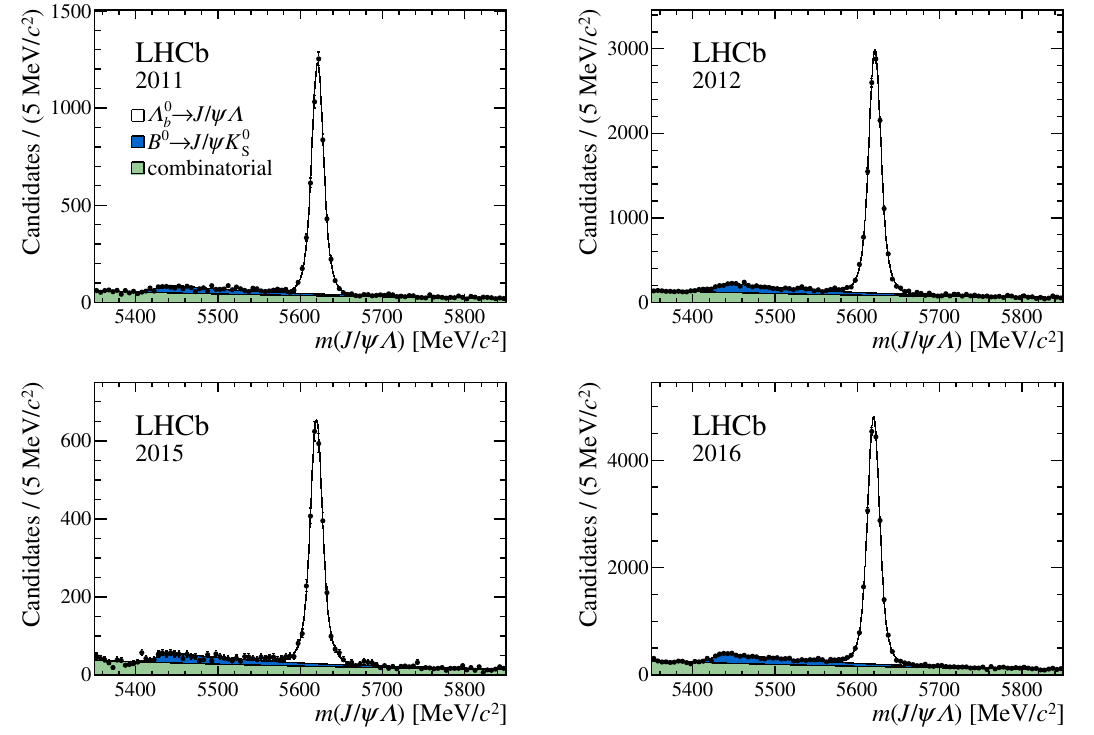
Figure 2 . Mass distribution of selected (cid:3) 0 ! J= (cid:3) candidates in (top-left) the 2011, (top-right) b the 2012, (bottom-left) the 2015 and (bottom-right) the 2016 data sets. The long and downstream categories have been combined. The results of (cid:12)ts to the distributions are